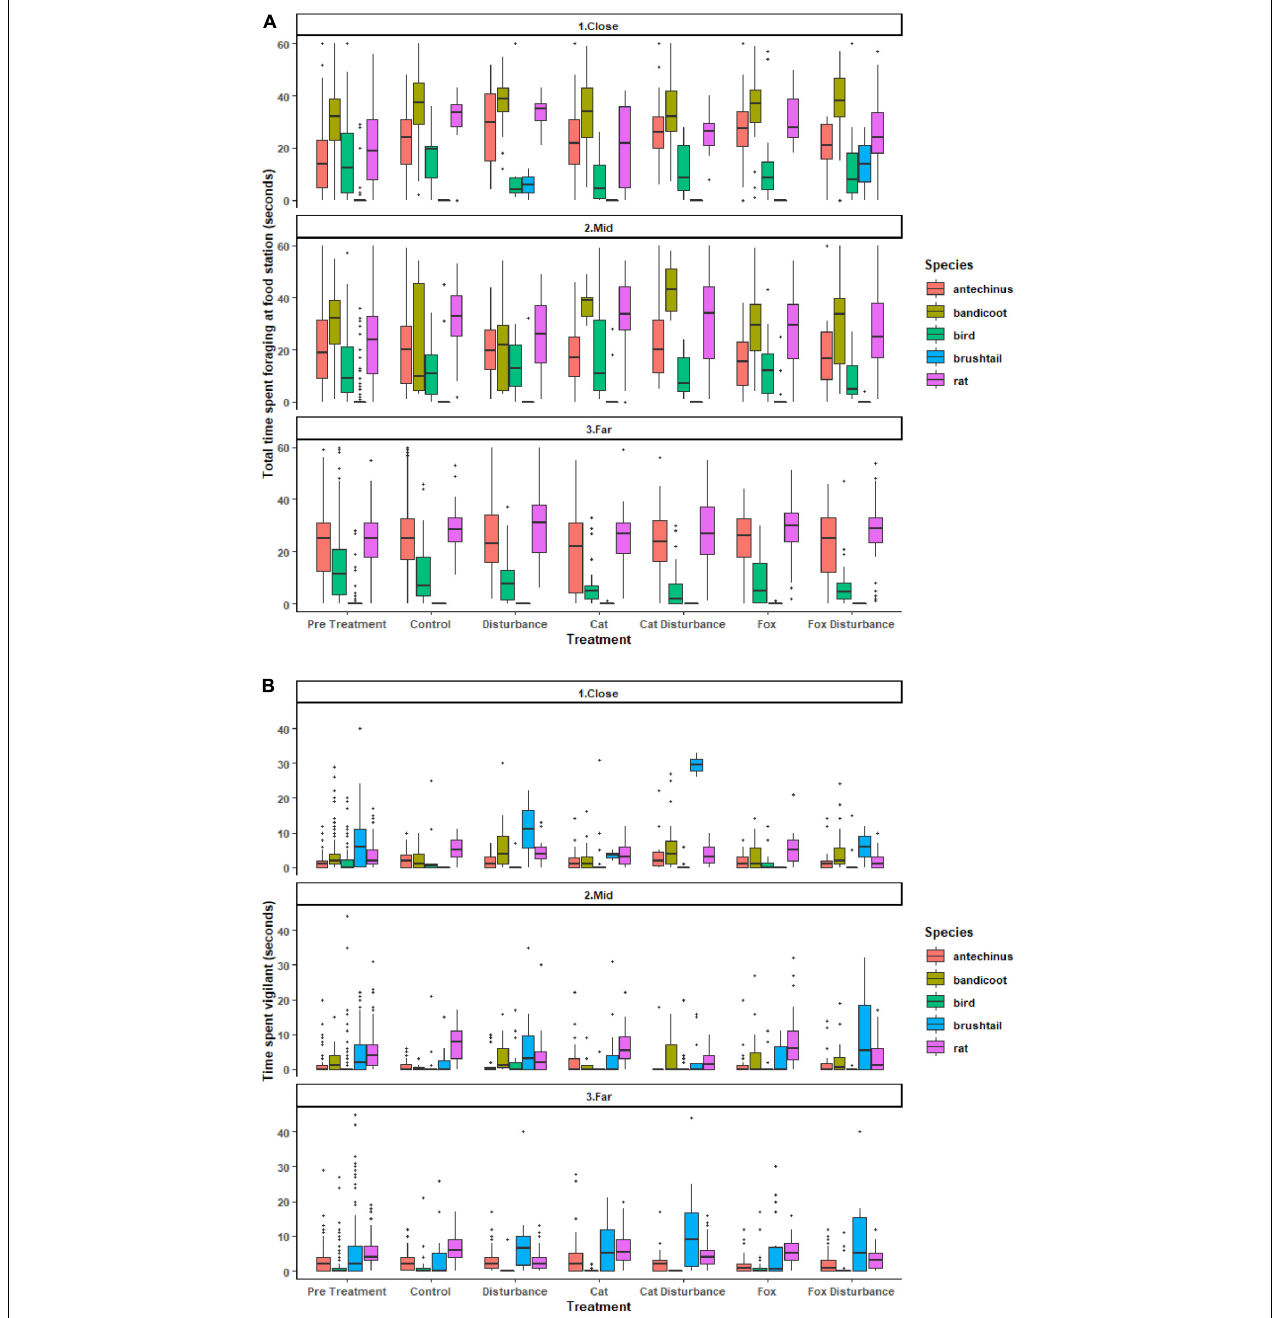
FIGURE 2 | Boxplots of raw data for the (A) average amount of time (seconds) spent foraging at a giving-up density station, and (B) average amount of time (seconds) spent in vigilant behavior on camera, for each species by treatment and environment. Vertical lines represent the standard error. Horizontal lines represent the mean. Dots represent measurements that were not consistently recorded but were retained in the